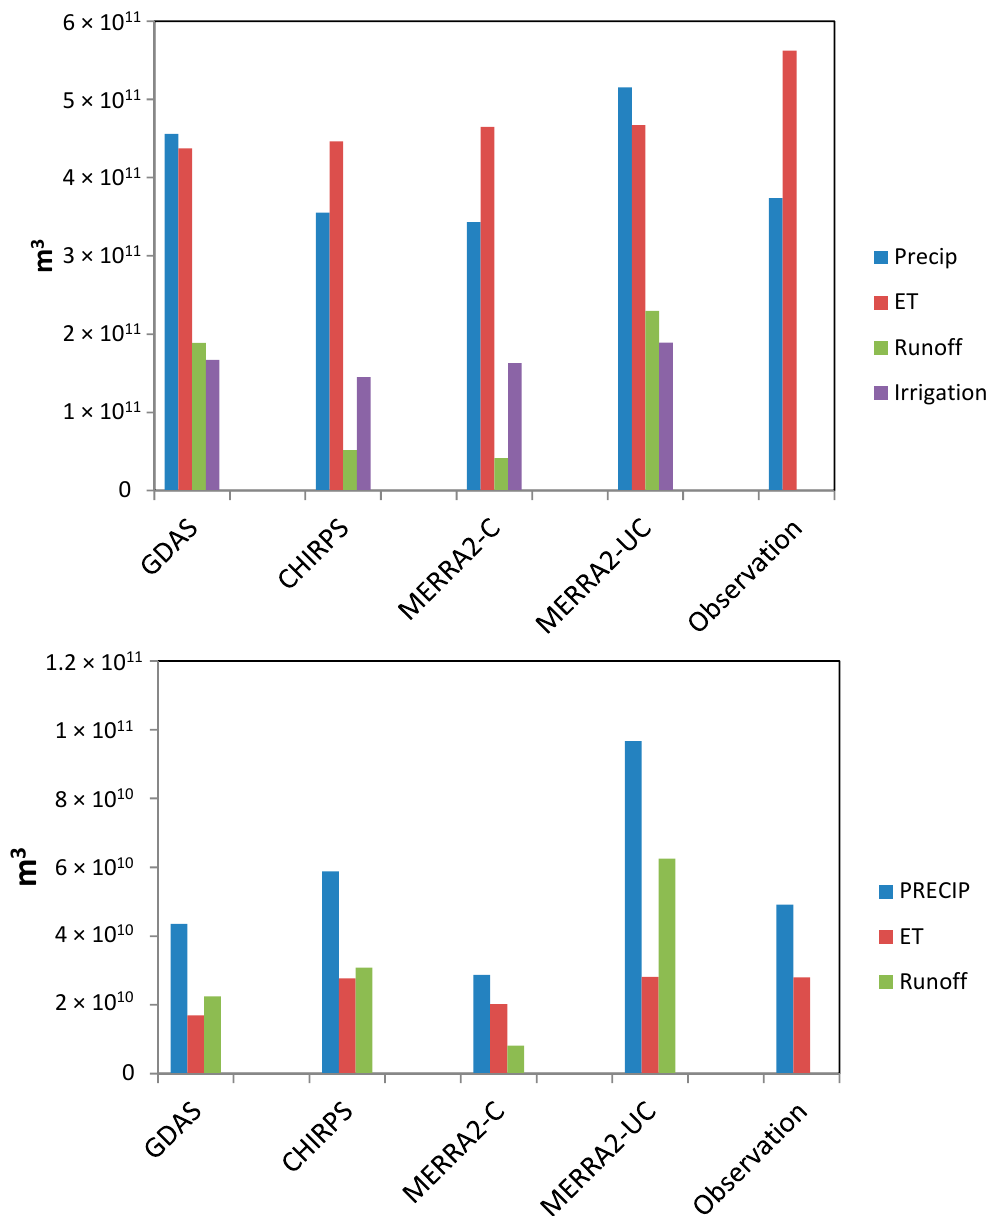
Figure 13. Average annual precipitation (m 3 ), average annual ET (m 3 ), average annual runoff (surface and sub-surface) (m 3 ), and average annual irrigated water (m 3 ) are plotted from model simulations and from observations. The top bar graph is plotted for Indus and the bottom one is plotted for the Kosi river basin.